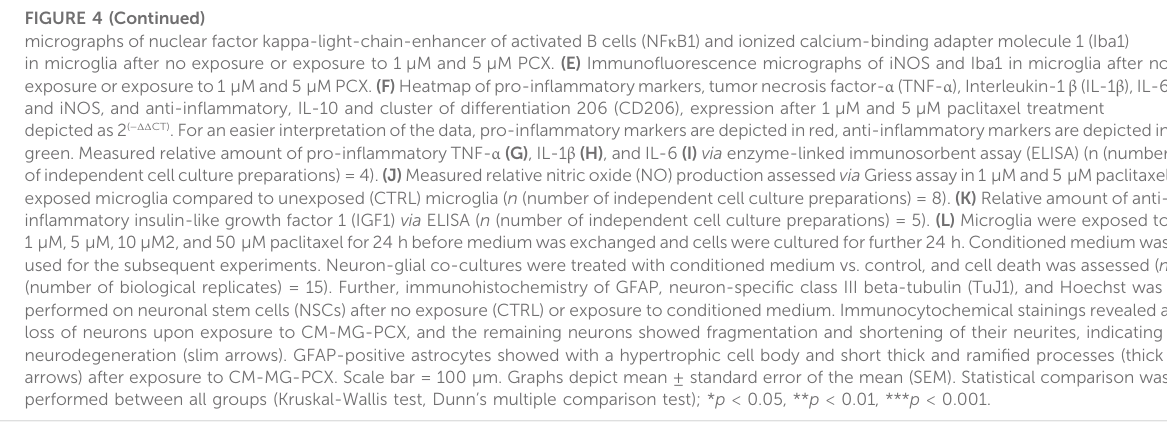
Figure 2) (Kim et al., 2016; Komiya et al., 2018). Neurons themselves can release ATP at their synapses (Fields